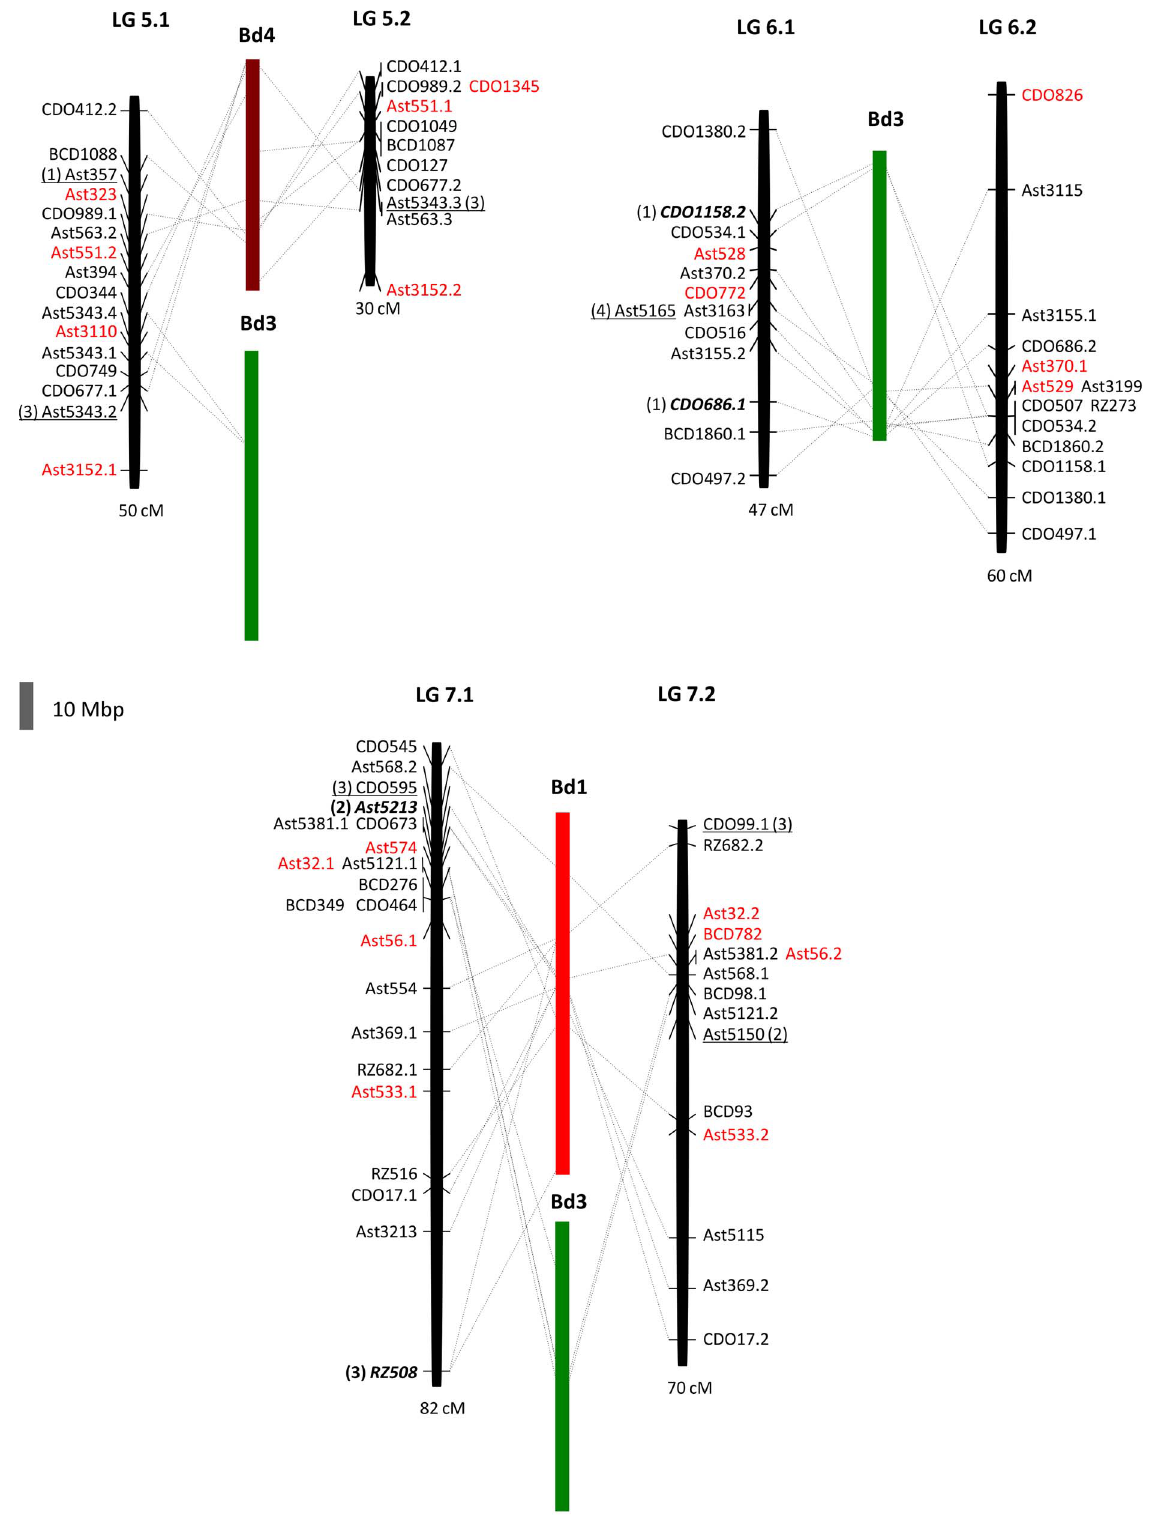
Figure 5. Comparative genome relationship on creeping bentgrass linkage groups 5 – 7 relative to Brachypodium distachyon . Comparative genome relationship between creeping bentgrass genetic linkage map and chromosomes of B. distachyon by determining the chromosomal location of sequences of the EST-RFLP markers mapped on the creeping bentgrass linkage map. The black bar represents each of the bentgrass linkage groups (total length in cM, below the bar) as shown in Figure 1. The colored bars represent each of B. distachyon chromosomes (Bd). The collinearity is represented by a dashed black line that links the RFLP markers with the highly similar sequences located in B. distachyon chromosomes. Markers in red have no significant sequences similarity with B. distachyon genome. Underlined markers have significant sequences